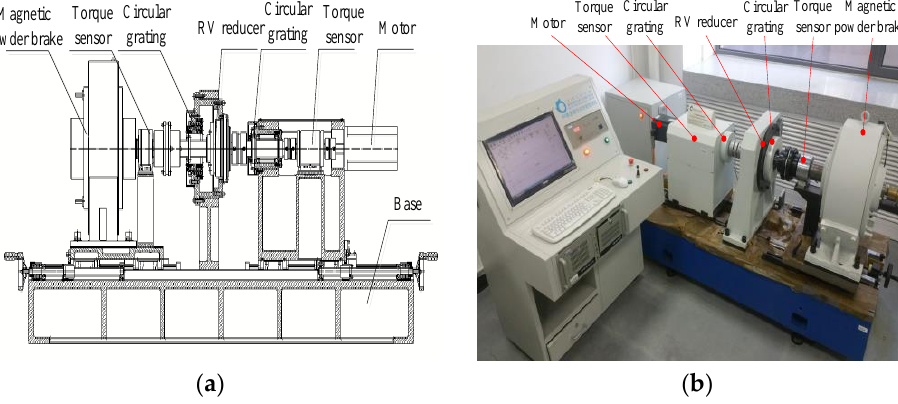
Figure 4. RV reducer comprehensive performance tester. ( a ) Structure diagram; and, ( b ) Physical view.